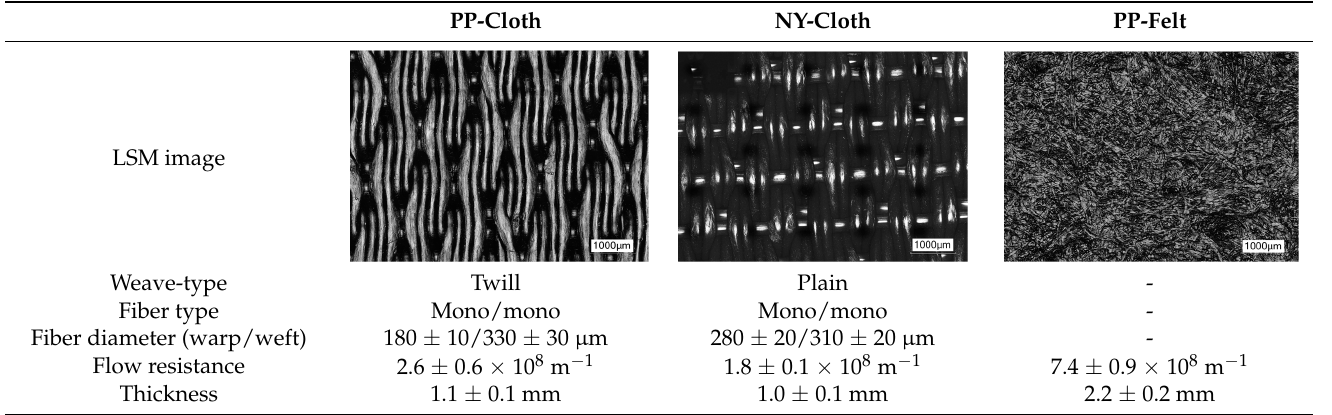
Table 2. Properties of tailings filtration filter media [17].